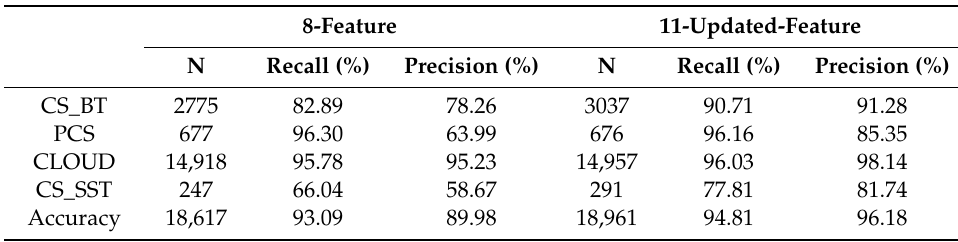
Figure 7. The changes of the cost for the cases of 11-feature (including 3 Community Radiative Transfer (CRTM) brightness temperatures (BTs)), 8-feature (excluding 3 CRTM BTs), and 11-updated-feature (excluding 3 CRTM BTs but adding CWV, surface air temperature, and water vapor contents as new features). Table 4. Recalls and precisions of the test dataset for the cases without CRTM BT input (8-feature) and without CRTM BT but with CWV as input (11-updated-Feature).